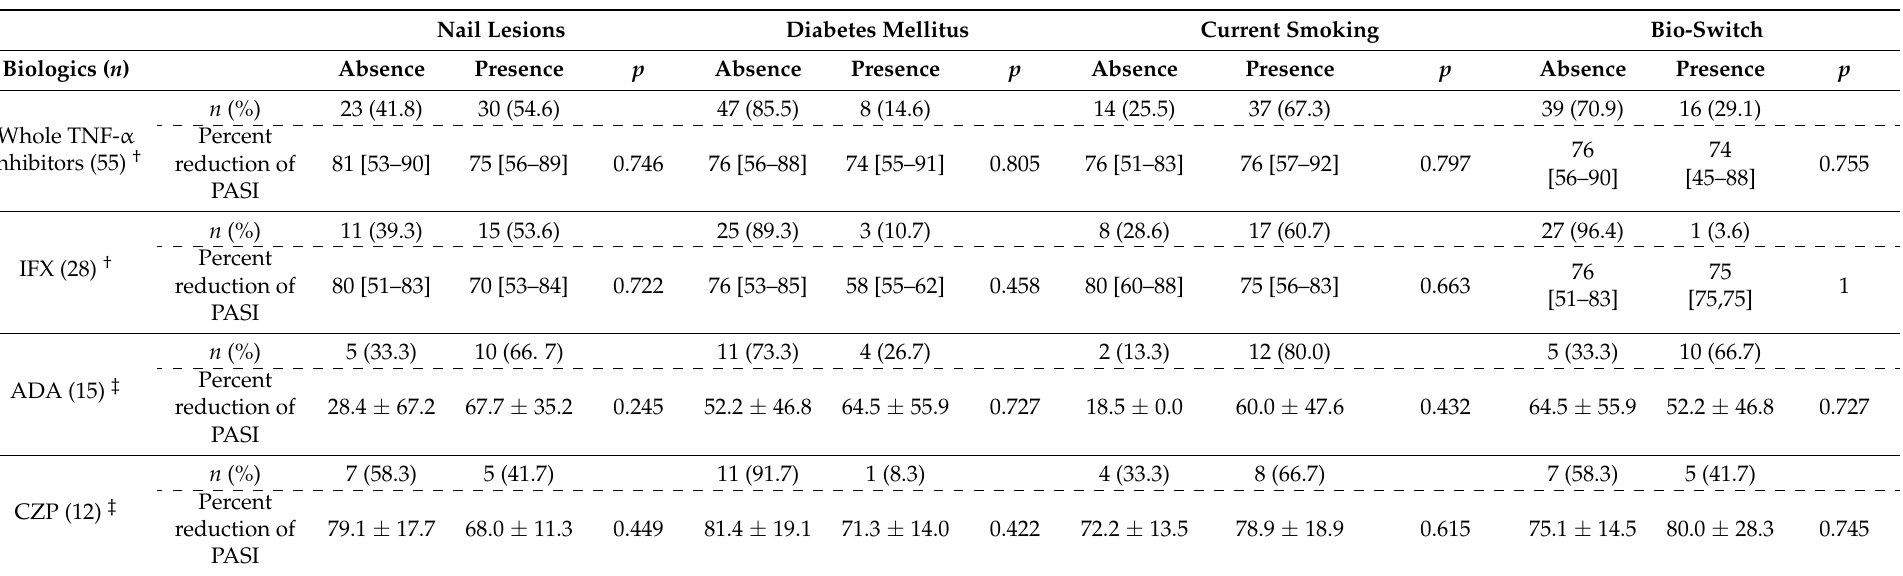
Table 8. The relationship between percentage reduction of psoriasis area and severity index (PASI) at week 52 versus presence or absence of nail lesions, diabetes mellitus, current smoking status or